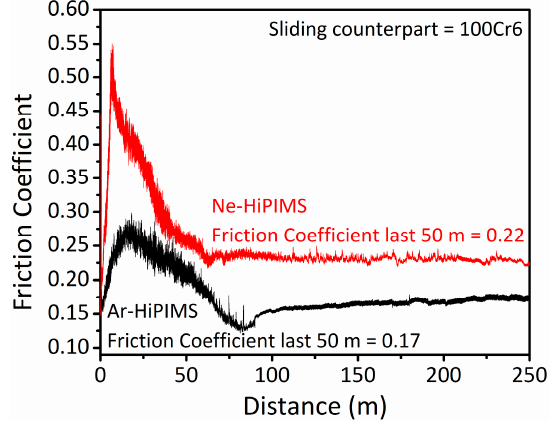
Figure 7. The friction coefficient of the DLC coatings deposited by the Ar and Ne-HiPIMS processes.